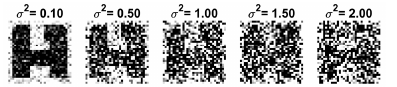
Figure 6. Examples of [A/H] with noise variance 𝜎 (cid:2870) ranging from 0.1 to 2.